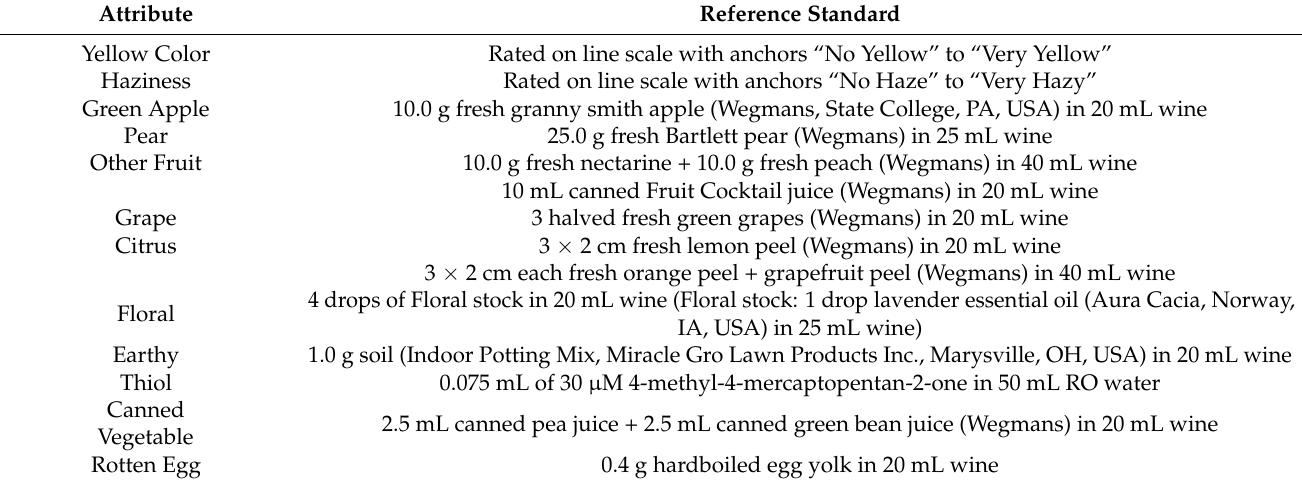
Table 1. Reference standards used for the Descriptive Analysis (DA) sensory attributes for wines made in 2018 (Year 1) and 2019 (Year 2) All standards were created in Bota Box Pinot Grigio (Bota Box Vineyards, Manteca, CA) base wine unless otherwise